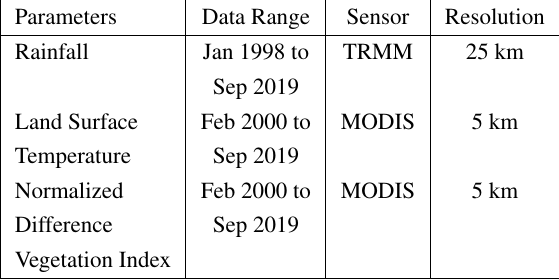
Table 1. Drought parameters used in the